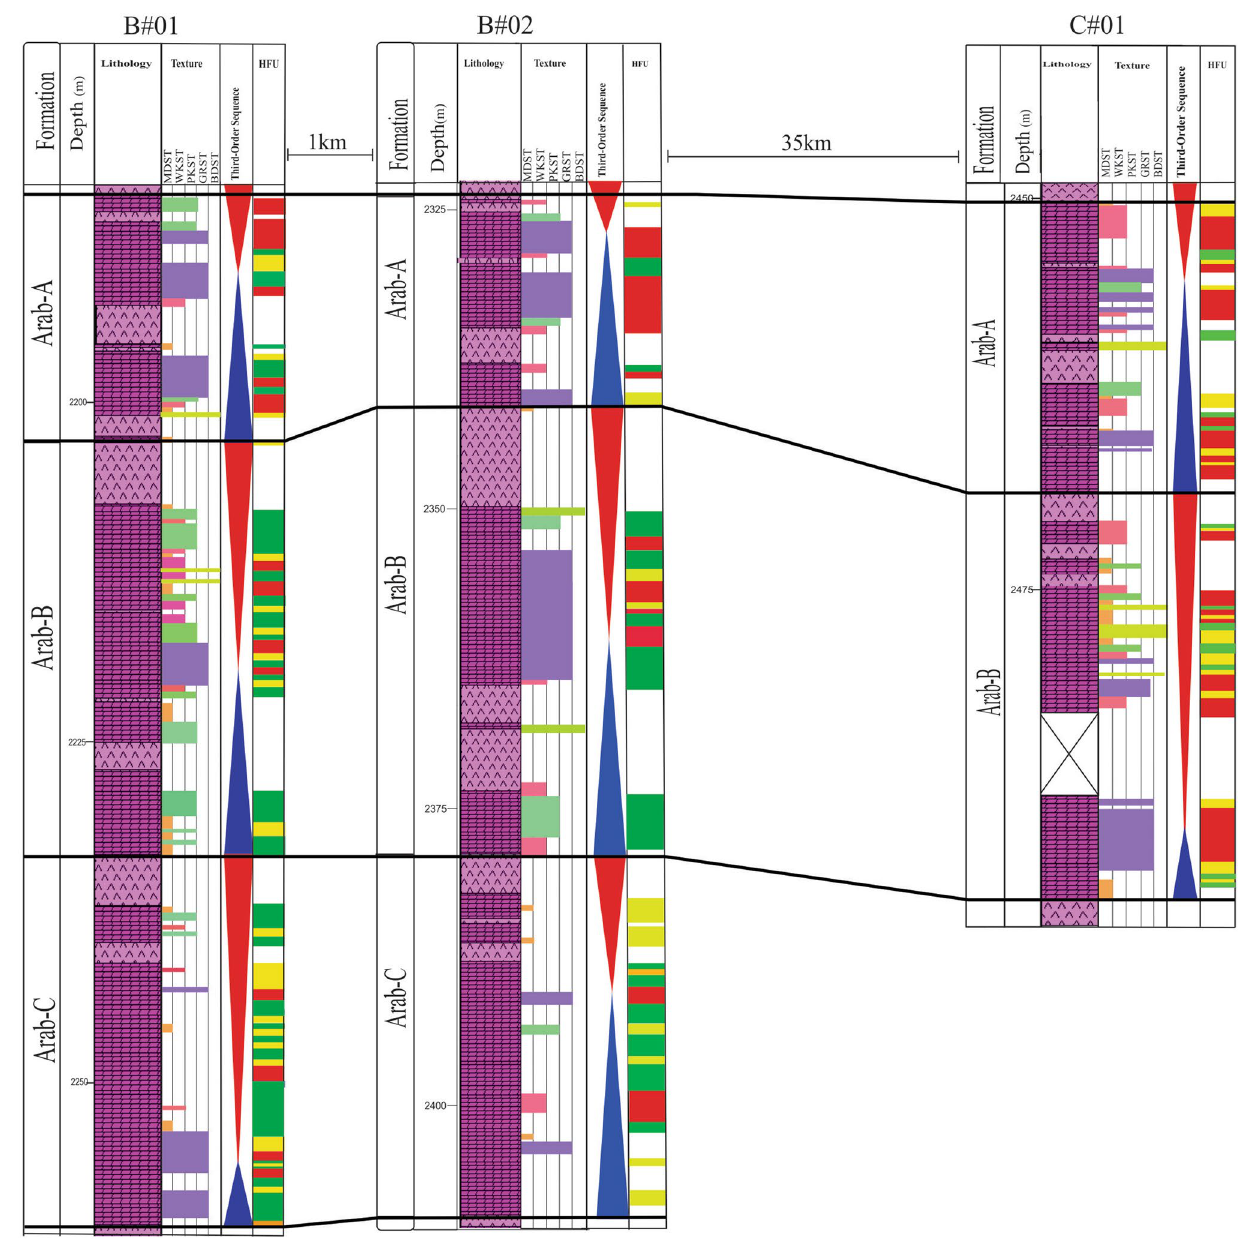
Fig. 14 Correlation among the studied wells based on stratigraphic properties and hydraulic flow units within a sequence stratigraphic frame-